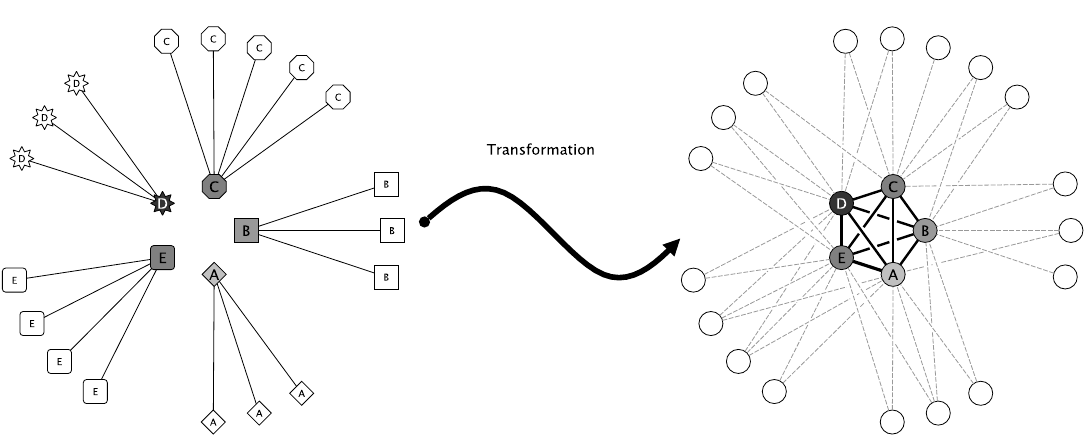
Figure 9. Transformation of VC networks to avoid project boundness of worker nodes.